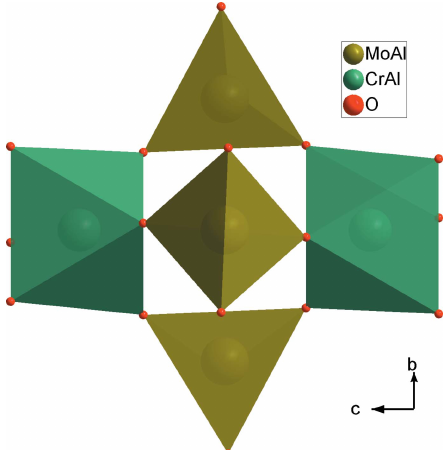
Figure 2 Projection of an M 1 2 M 2 3 O 18 unit along the a axis.